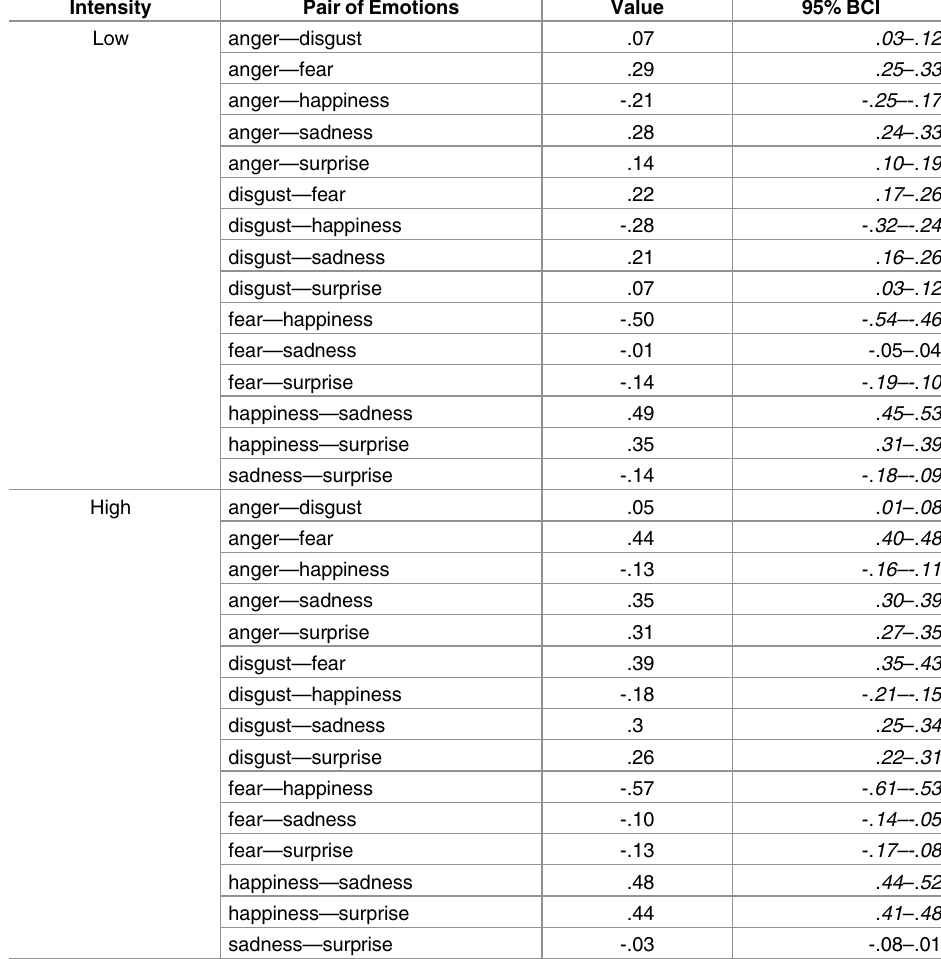
Table 3. Bayesianpairwise comparisons across emotions by type of intensity with accuracyin emo- tion recognition as dependent variable.